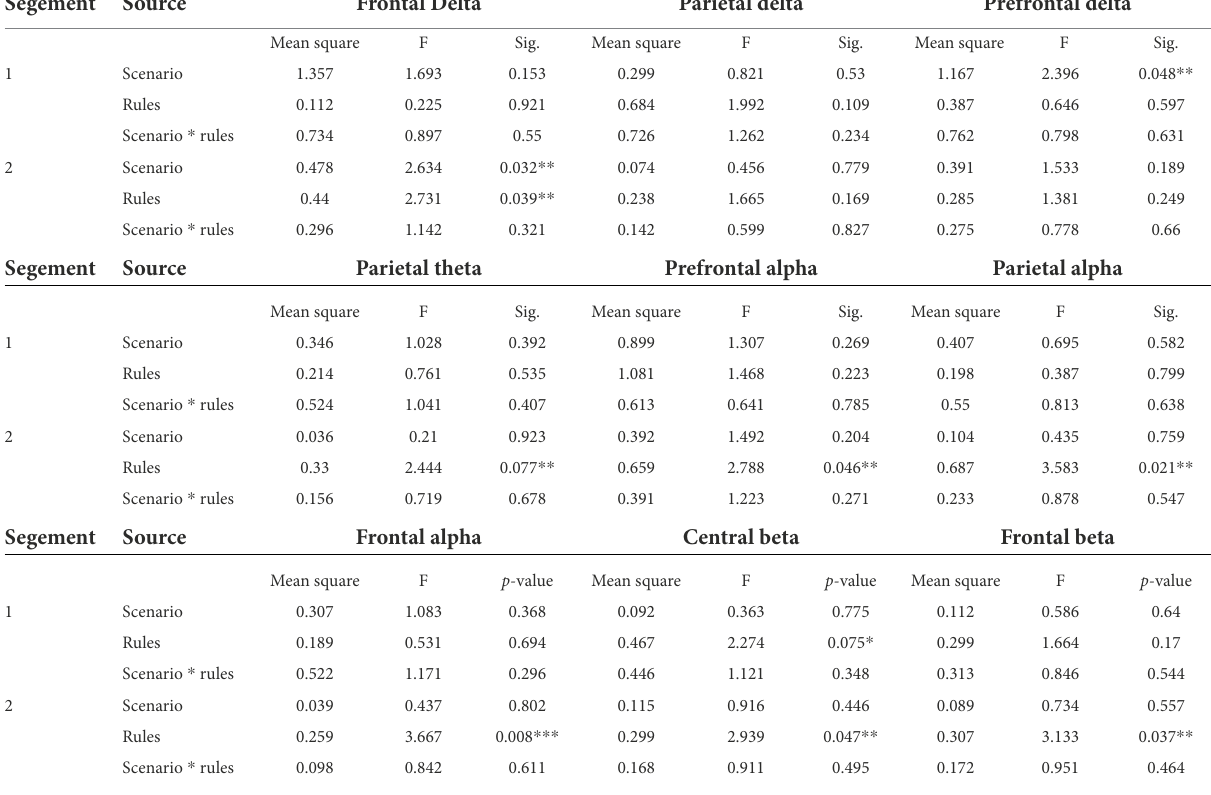
TABLE 7 Effects of physicians’ response on EEG